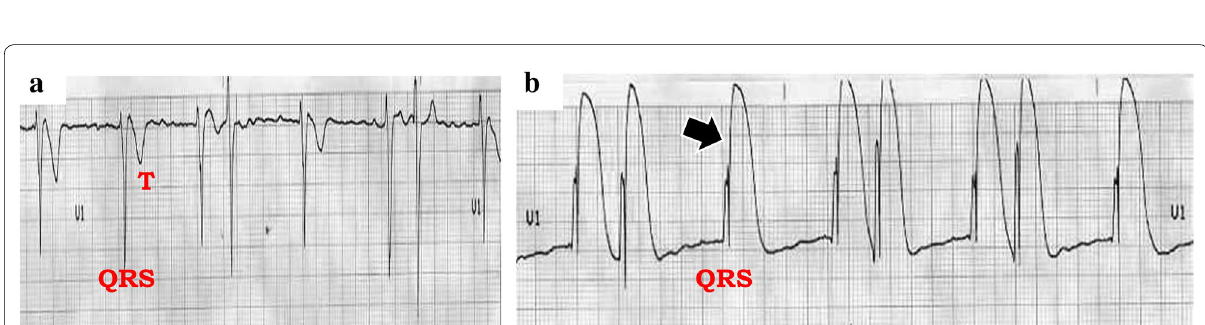
Fig. 4 Intracavitary ECG (lead V1) showing the cardiac electrical activity when the EC is free-floating into the RV ( a ) and when this is contacting the endocardium of the RV ( b ), as demonstrated by a subepicardial injury pattern